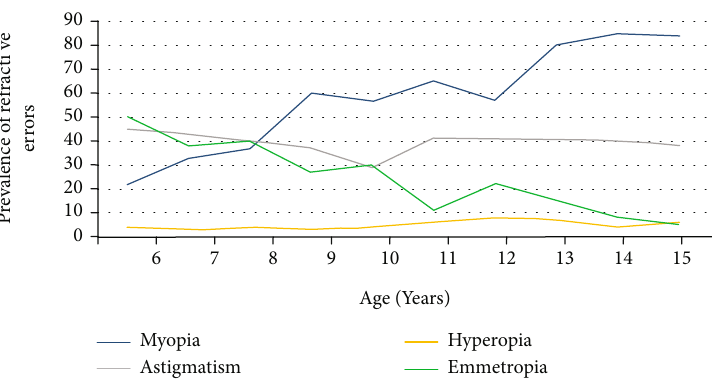
Figure 1: Prevalence of refractive errors of myopia, hyperopia, astigmatism and emmetropia strati fi ed by